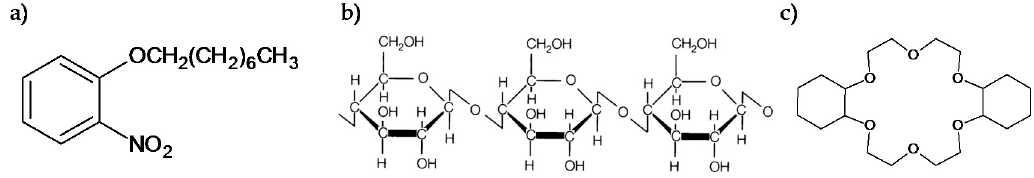
Figure 11. Chemical structure of 2-NPOE ( a ); CTA ( b ); and DCH18C6 ( c ).